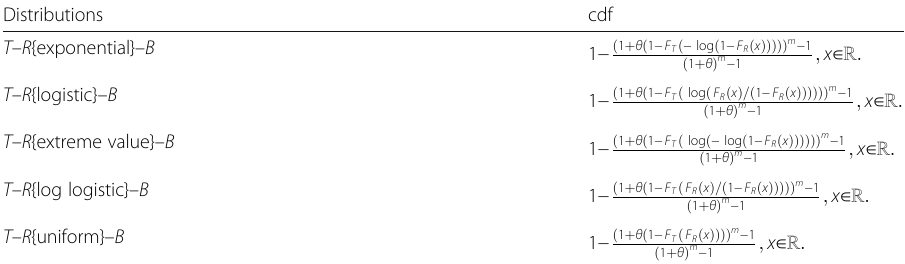
Table 4 Different T – R { Y } – B distributions Distributions